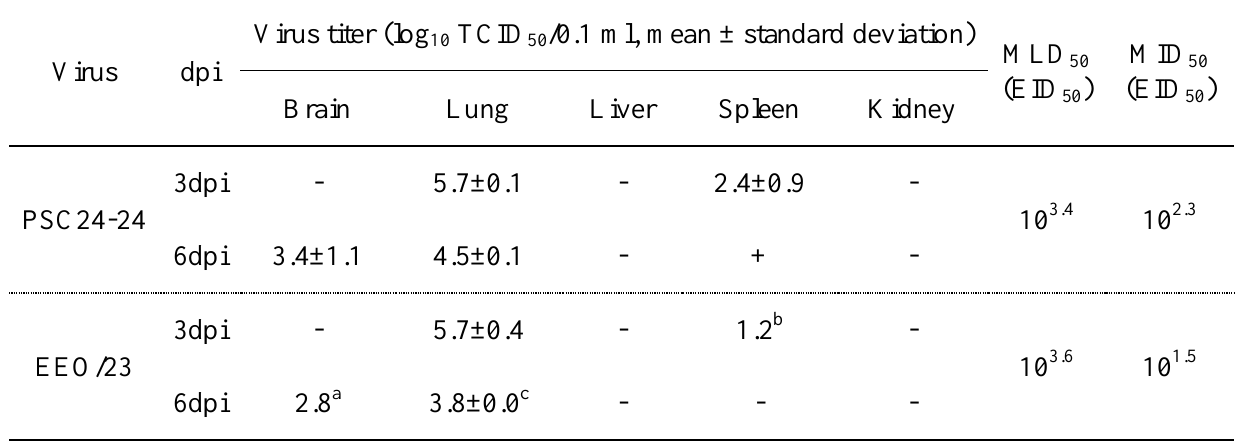
Table 5. Virus distribution in experimentally inoculated